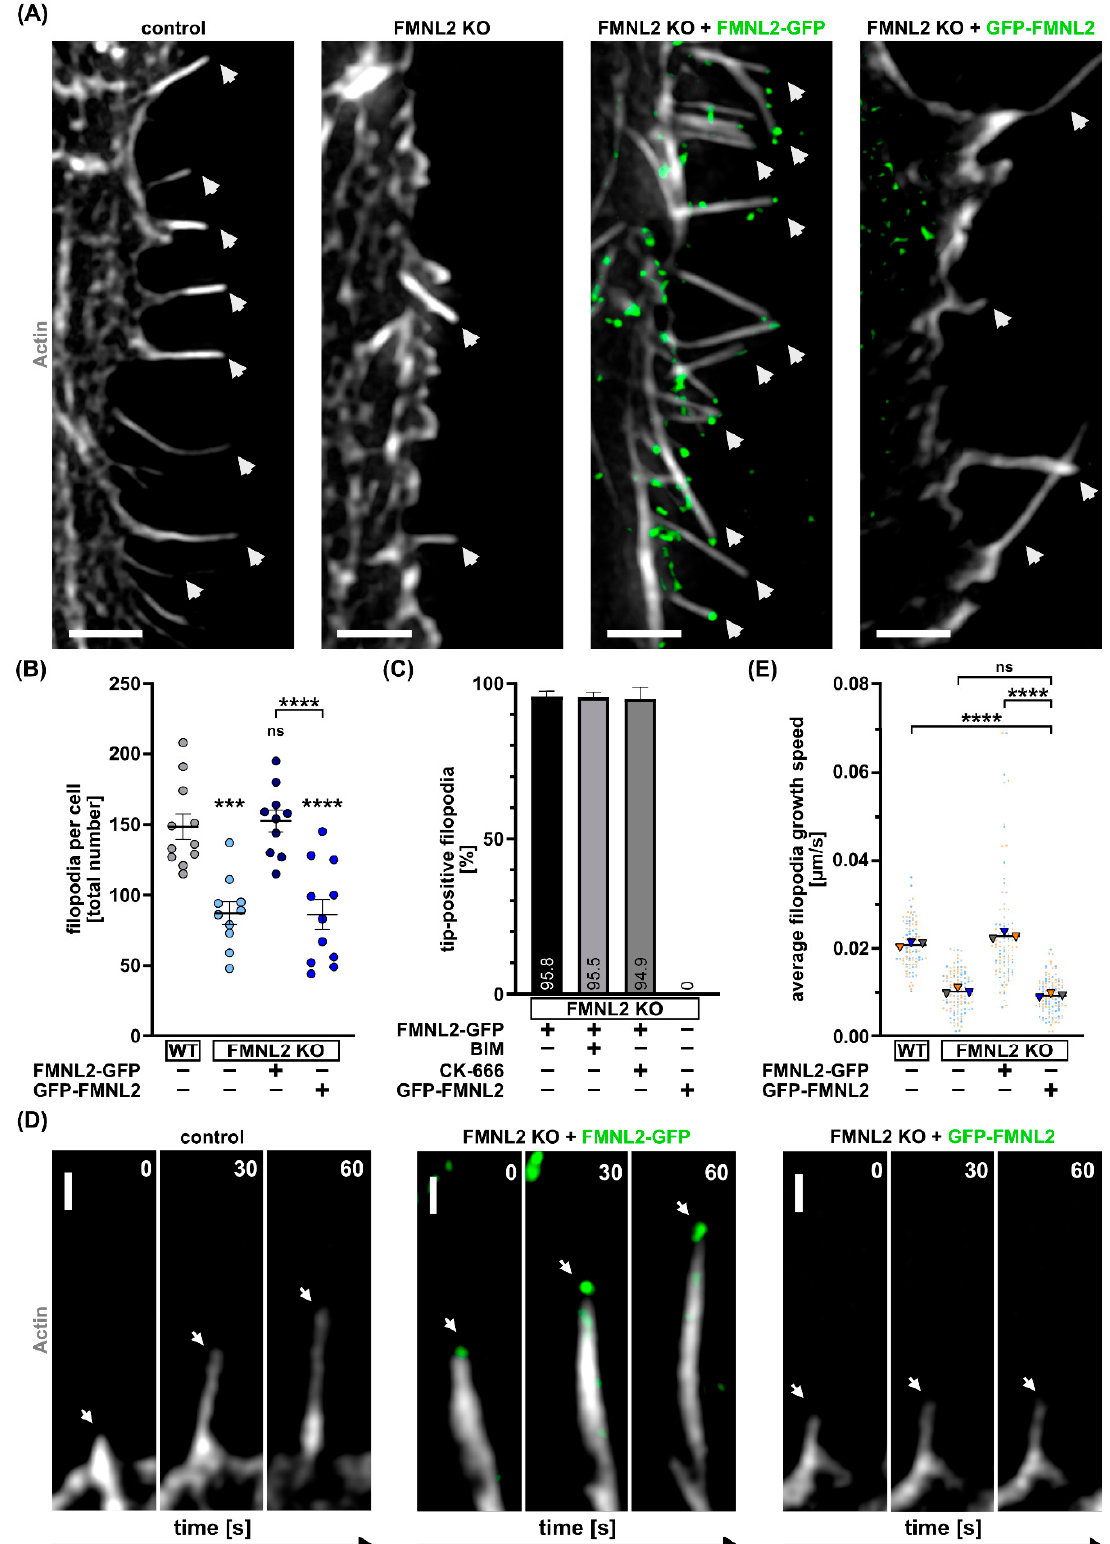
Figure 2. N-myristoylation of FMNL2 is required for FMNL2-dependent filopodia formation. Sections of MCF10A cells (Control = wildtype; FMNL2 KO; FMNL2 KO + FMNL2-GFP; green) exhibiting filopodia ( A ) and quantification of total number of filopodia per cell ( B ). Cells were transfected with actin-chromobody SNAP (white, SNAP-cell 647 SiR) and FMNL2 KO cells were additionally